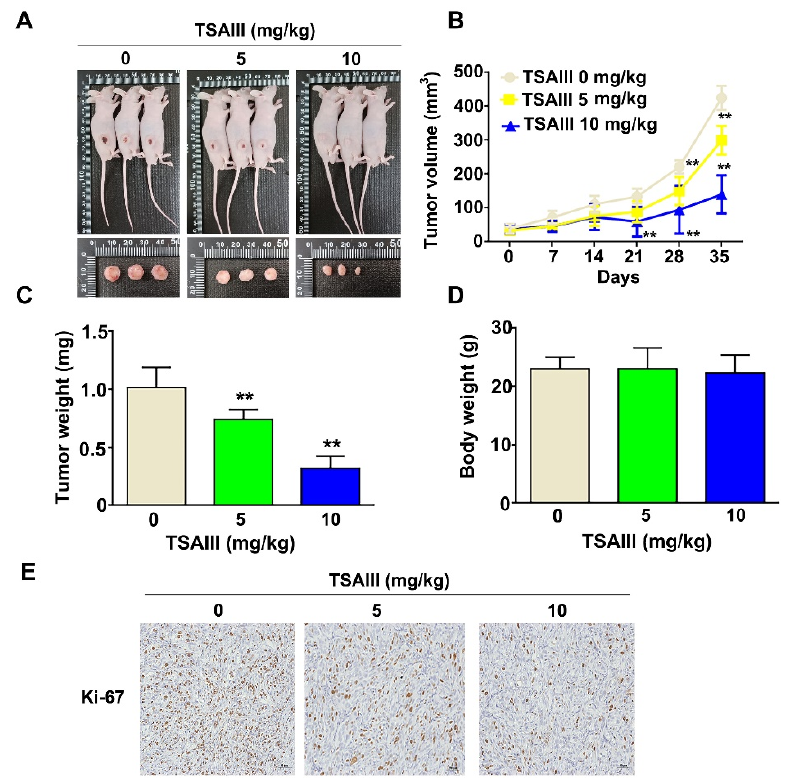
Figure 6. Antitumor effects of TSAIII in GBM8401-xenograft mice. Five-week-old female BALB/c nude mice were treated with normal PBS (control), low-dose TSAIII (5 mg/kg, 3 times/week), or high-dose TSAIII (10 mg/kg, 3 times/week) for 35 days. ( A ) Images of representative tumor tissues from each group; ( B ) tumor volume was measured one time per week until 35 days; ( C ) tumors weight for each group; ( D ) body weight for each group; ( E ) immunohistochemically staining with Ki-67 antibody in paraffin-embedded tumor sections from each group. Data are represented as the mean ± SE. ** p < 0.01 vs. control group.